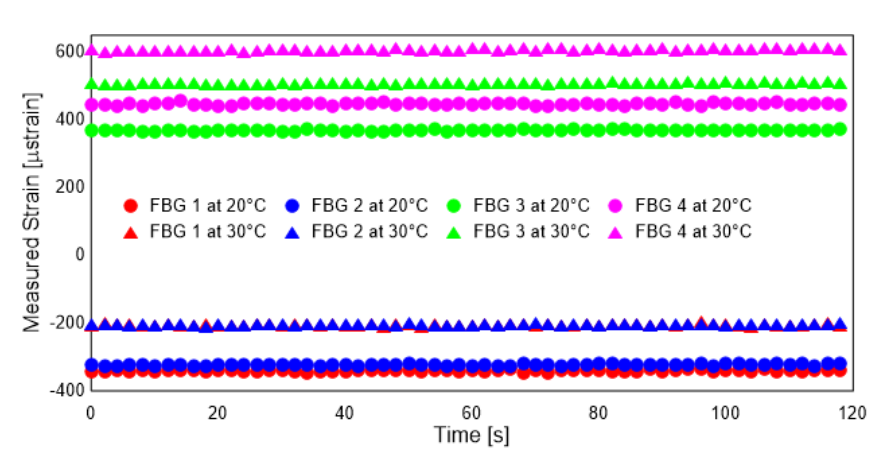
Figure 5. Response of beam under bending loads.